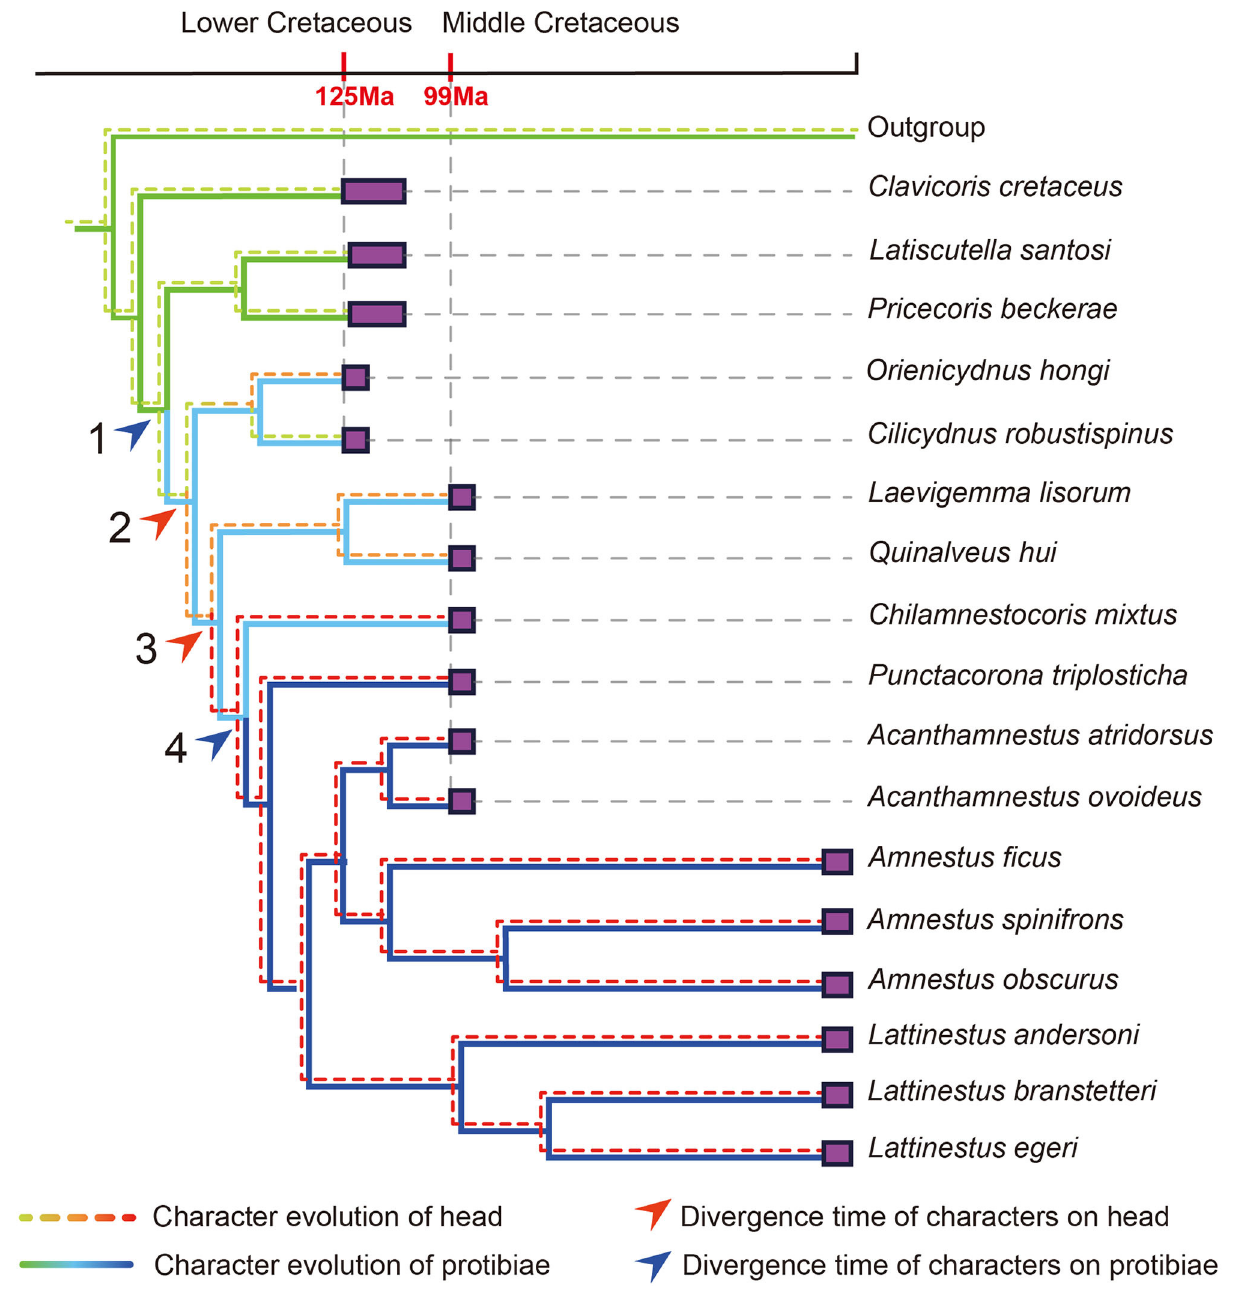
(Popov, 1986), Pricecoris beckerae (Pinto and Ornellas, 1974), and Latiscutella santosi (Pinto and Ornellas, 1974), among many others. Species of the second morphotype have the surface of the body relatively smooth, with tiny and distinct